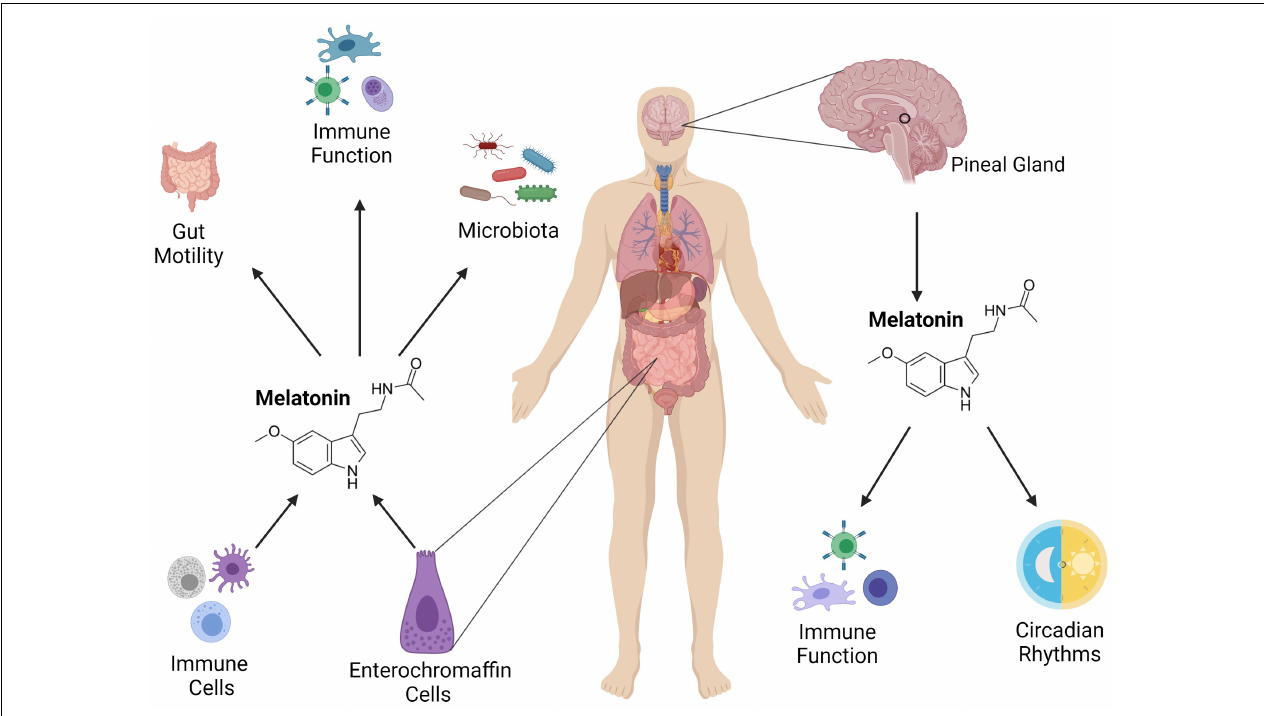
FIGURE 2 | The role of melatonin in the intestinal immune system. Melatonin is produced from the pineal gland, and it influences circadian rhythms and immune function. It is also secreted in the gut from enterochromaffin and immune cells where it regulates GIT motility, immunity and the microbiota. Adapted from Ma et al. (2020) Medicinal Research Reviews. Image created using